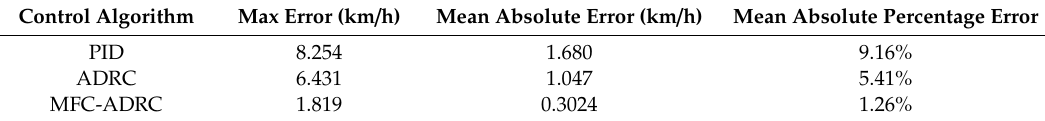
Figure 6. Speed tracking results for Case 2. Table 4. Tracking error statics with vehicle mass 2100 kg and incline 6°.